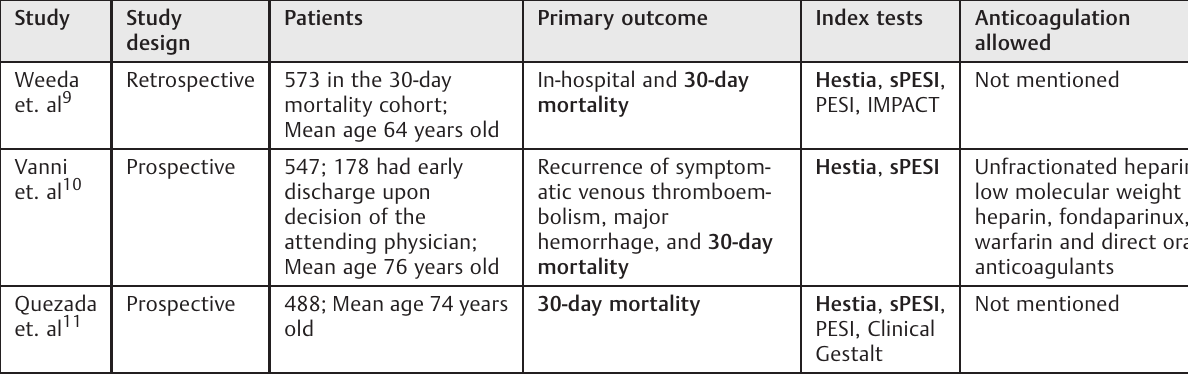
Abbreviations: IMPACT, In-hospital mortality for pulmonary embolism using claims data; PESI, pulmonary embolism severity index; sPESI, simpli fi ed pulmonary embolism severity